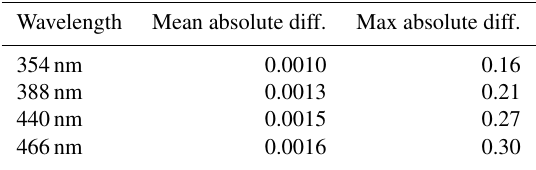
Table 4. Sensitivity to wind speed. Table 5. Sensitivity to chlorophyll.